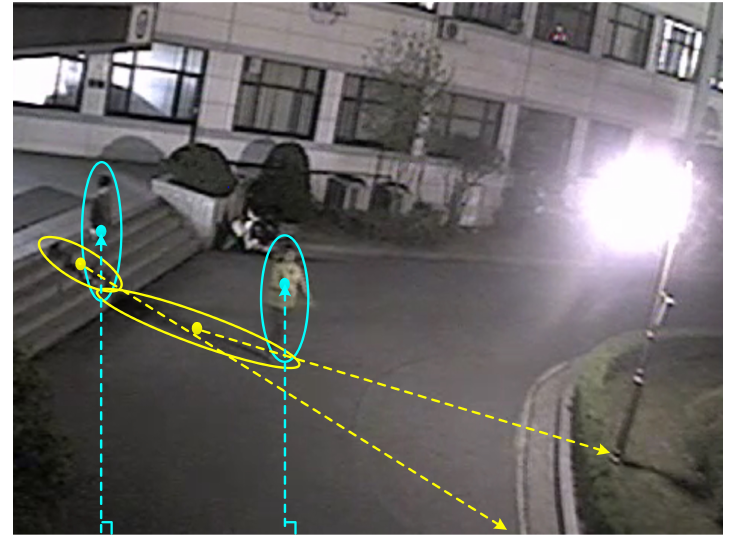
Figure 3. Shapes of objects and their shadow regions in nighttime video